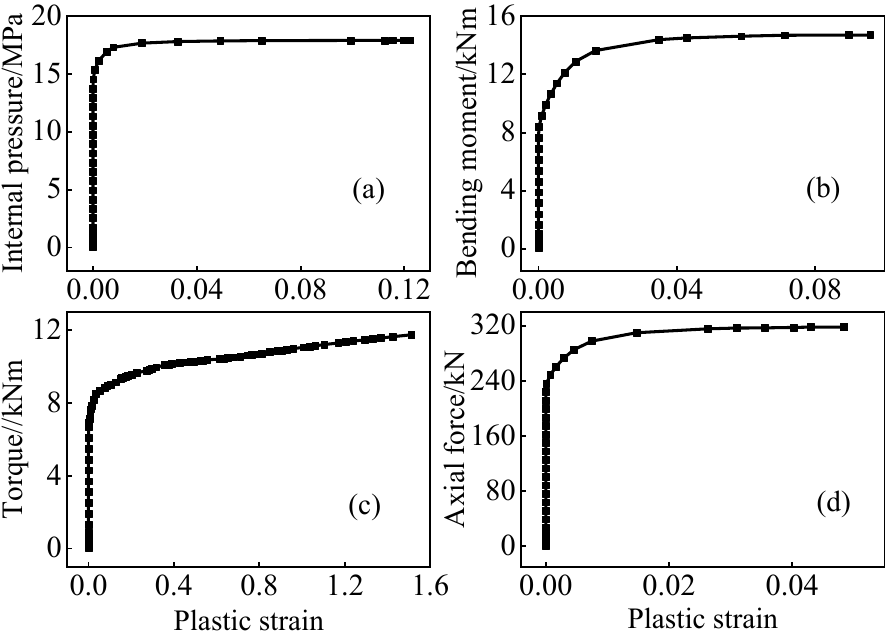
Figure 5. The load vs. plastic strain curves of a straight pipe with a local wall-thinning defect under single loads: ( a ) internal pressure; ( b ) bending moment; ( c ) torque; ( d ) axial